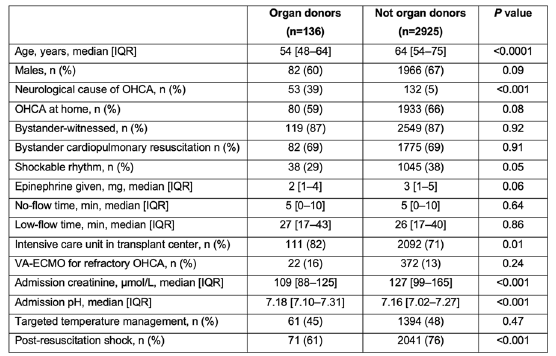
Table: Utstein characteristics of patients with out-of-hospital cardiac arrest